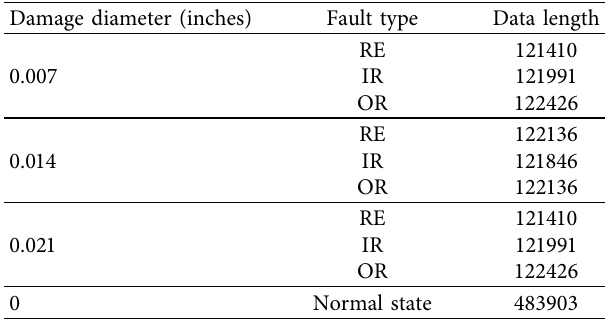
Table 1: Bearing data at DE under the conditions of 12kHz